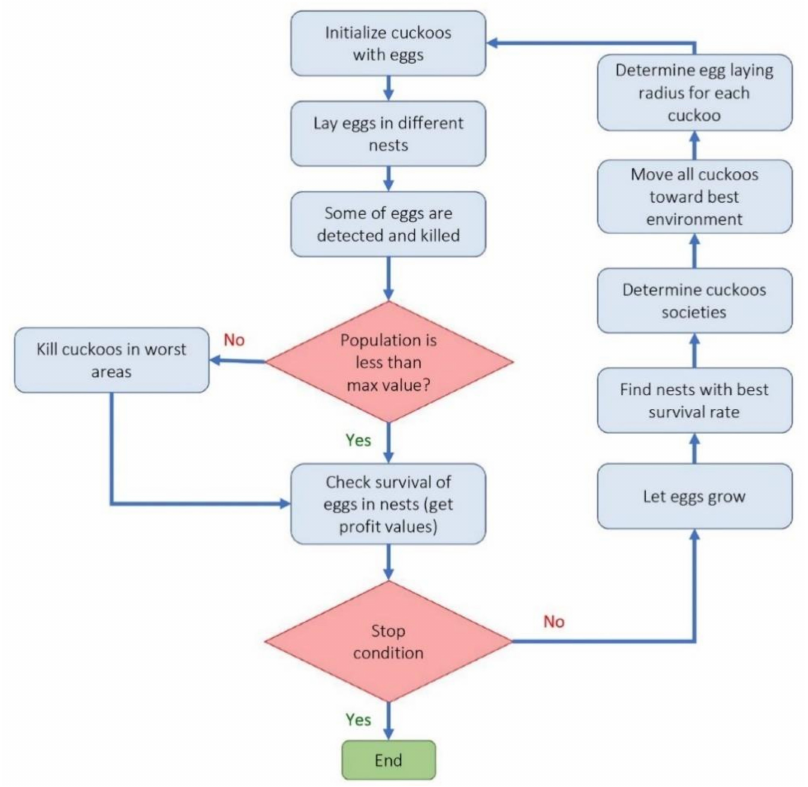
Figure 2. Flowchart of optimization process using cuckoo